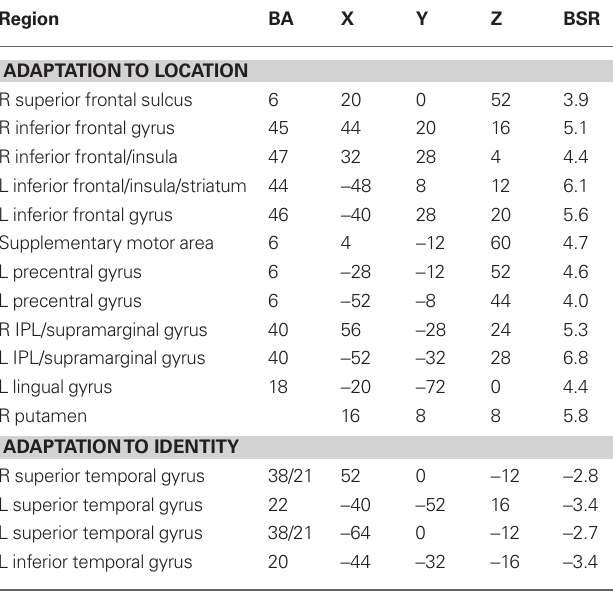
Table 3 | Brain regions with domain-specific adaptation effects in young adults.